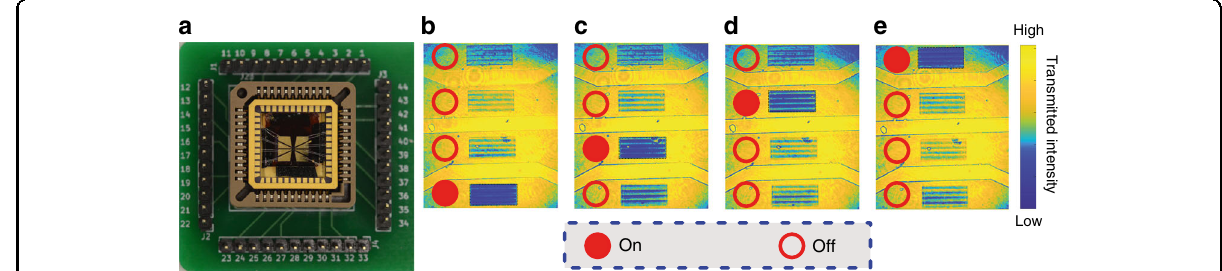
Fig. 4 The addressable metasurface pixels. a Image of the metasurface mounted on a PCB for electrically programable pixels. b – e Images of the metasurface pixels driven by different microheaters at 780 nm